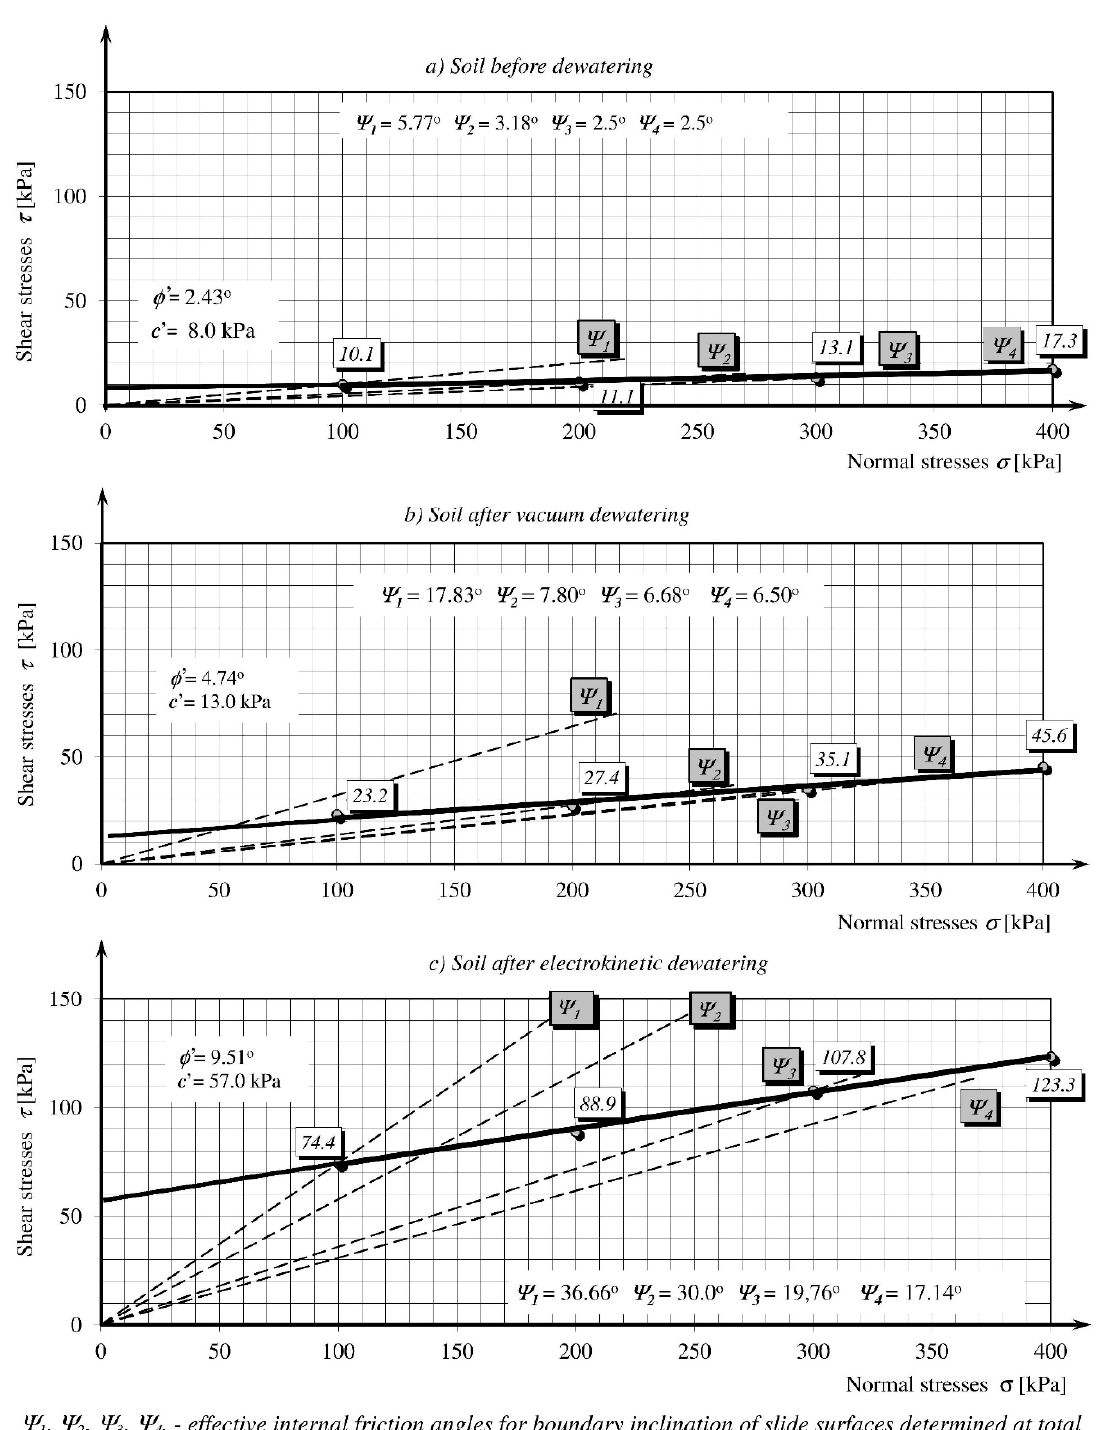
Figure 11. Diagram of the strength parameters of the contact layer soil before and after conducting dewatering by three methods (gravitational, vacuum, and electrokinetic).